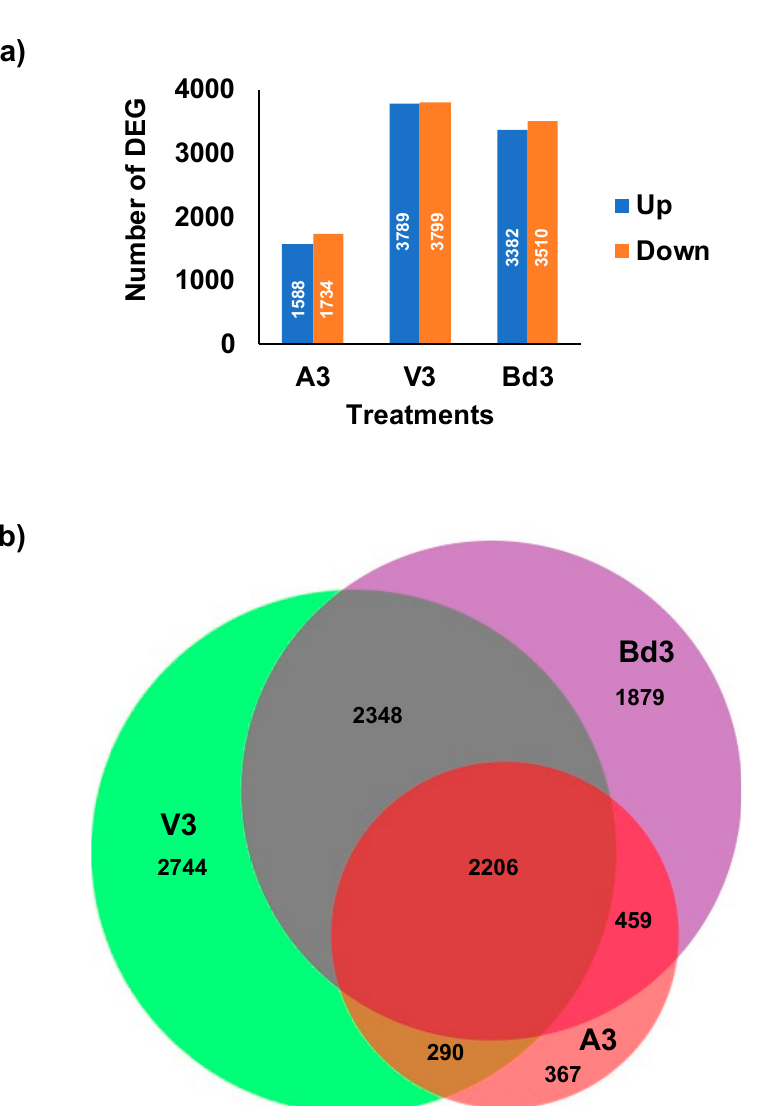
Figure 3. Up- and down-regulated differentially expressed genes (DEG) in larvae at 3 days after hatch (DAH). ( a ) The number of DEG (with log2 expression >1 or < − 1 and adjusted p -value < 0.05) that showed up-regulation (blue bars) and down-regulation (orange bars) in avirulent (A3) and virulent (V3) larvae feeding on host wheat at 3 DAH and in larvae (Bd3) feeding on nonhost Bd plants at 3 DAH. ( b ) Venn diagram showing DEG that are uniquely expressed and common between A3, V3, and Bd3 larvae.